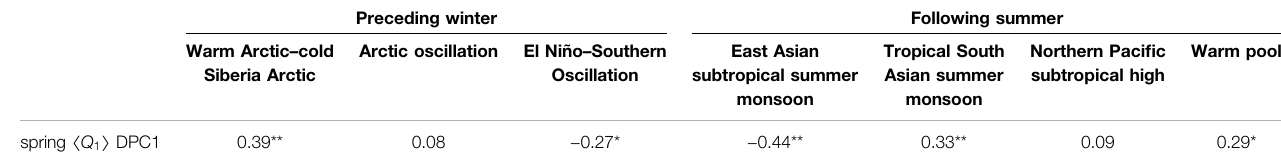
TABLE 1 | Correlation coef fi cients of the DPC1 series with the monsoon, circulation and SST indices for 1979 – 2020 spring heat sources.